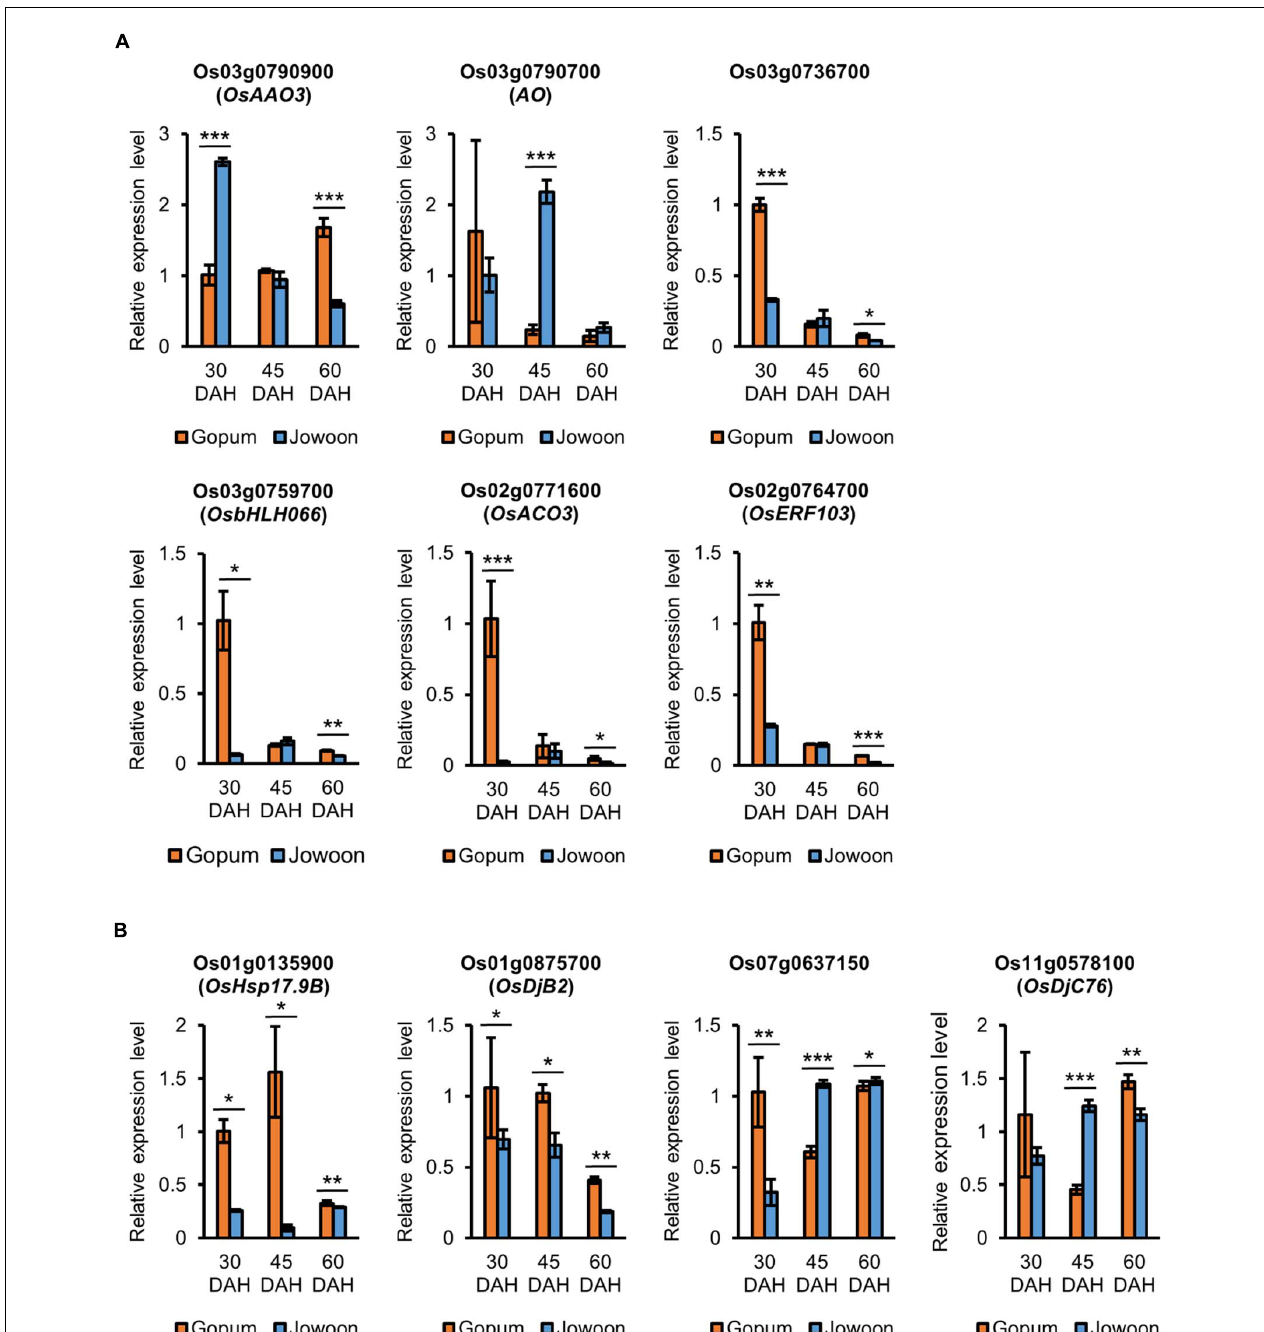
FIGURE 5 | Relative expression levels of pre-harvest sprouting (PHS)-related candidate genes by quantitative real-time PCR (qRT-PCR). (A) Relative expression levels of abscisic acid (ABA)- and ethylene-related genes. ABA-related genes (top) and ethylene-related genes (bottom) are shown. (B) Relative expression levels of heat shock protein ( HSP ) genes. Data represent mean ± standard error of mean (SEM; N = 3). Significance is determined by Student’s t- test, * P < 0.05, ** P < 0.01, and *** P <